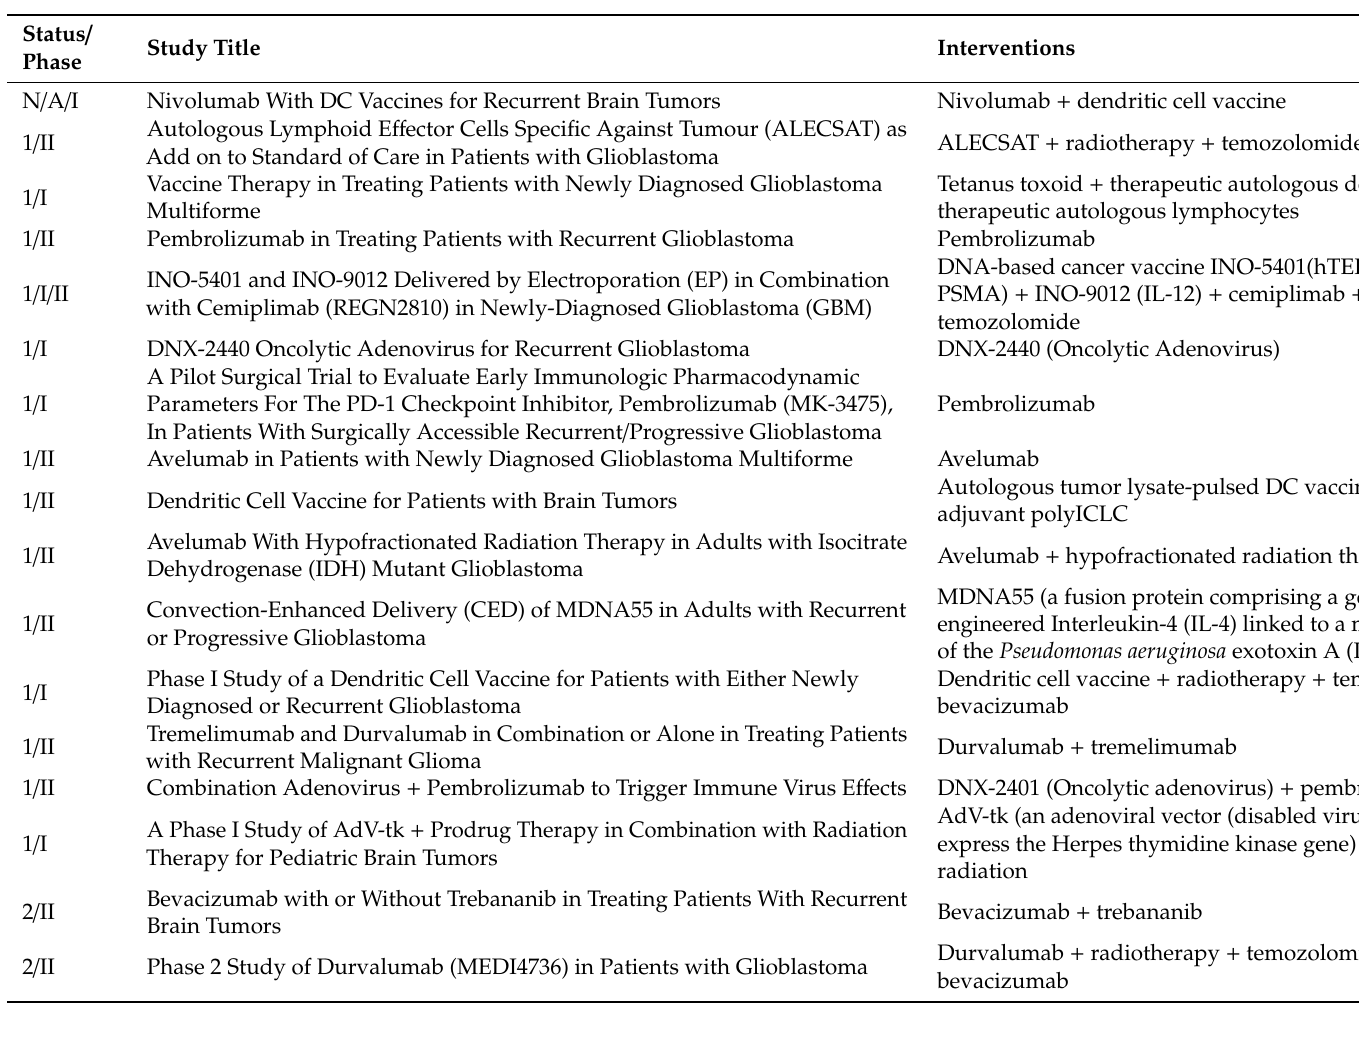
Table 1. Ongoing clinical